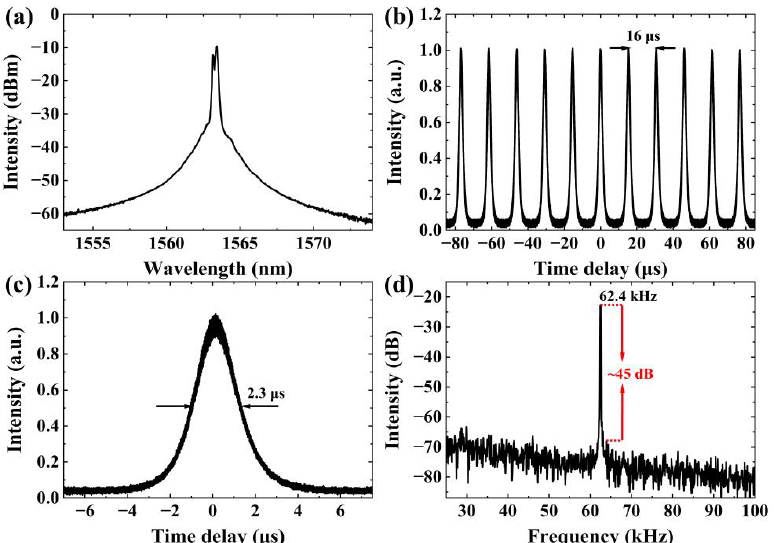
Figure 6. Experimental results of EDFL for a pump power of 135 mW. ( a ) Optical spectrum. ( b ) Q-switched pulse train. ( c ) Single pulse profile. ( d ) RF spectrum.